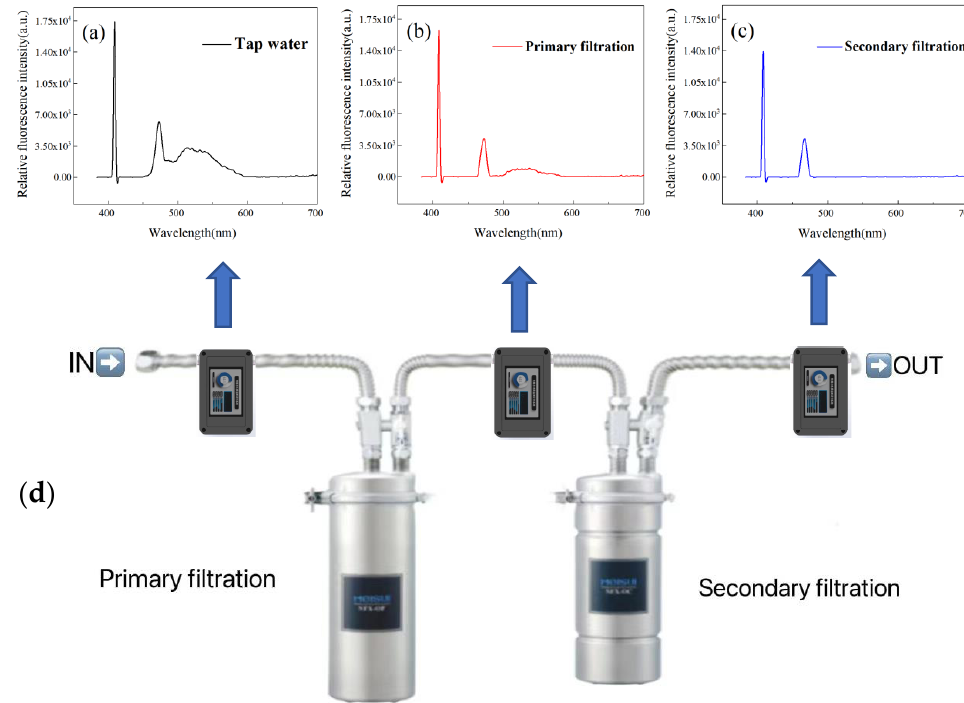
Figure 3. Laser spectral comparison of tap water, primary filtered water, and secondary filtered water. ( a ) Laser spectra of tap water; ( b ) Laser spectra of primary filtered water; ( c ) Laser spectra of secondary filtered water; ( d ) The two-stage water filtration system and three water quality monitoring spots. Table 3. Water quality measurement results for tap water, primary filtered water, and secondary filtered water.